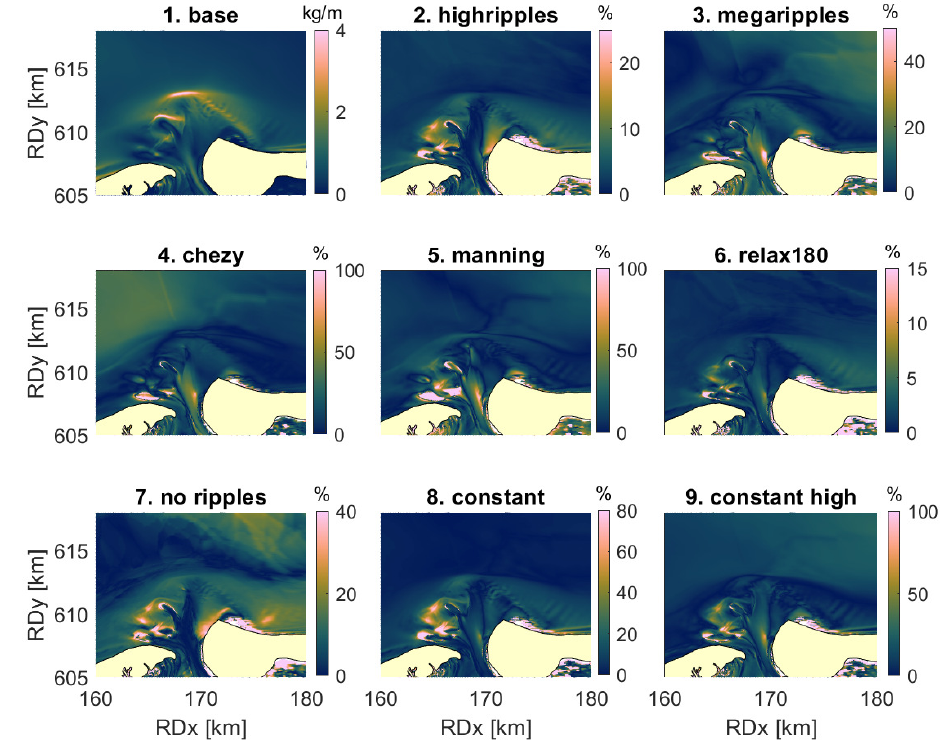
Figure 12. Time-integrated bedload transport q b during the storm (1), and absolute relative difference in q b of all other scenarios with the base scenario during the storm (2–9).